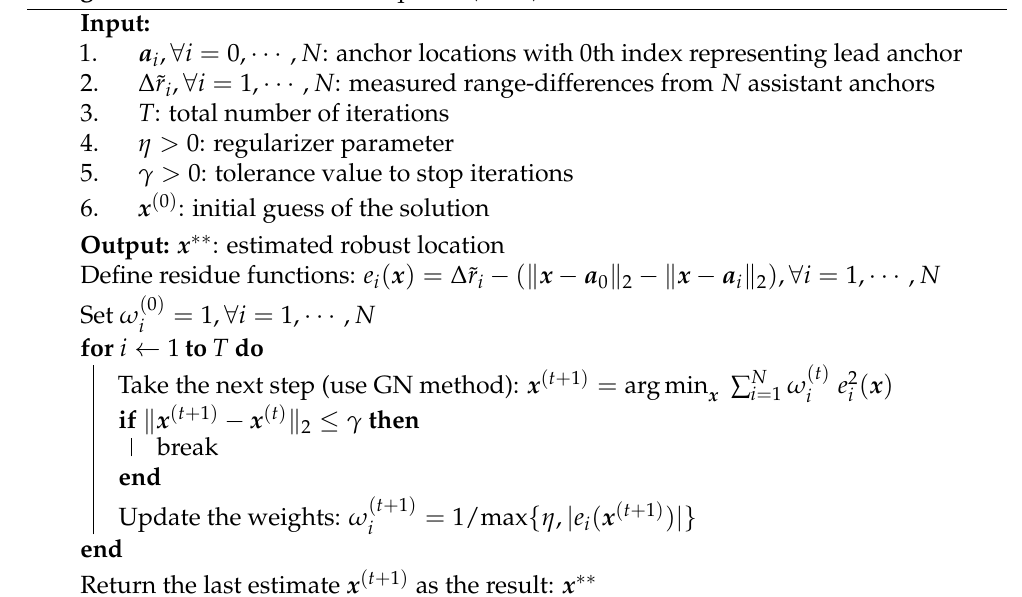
Algorithm 1: Least-Absolute-Squares (LAD) Robust Location